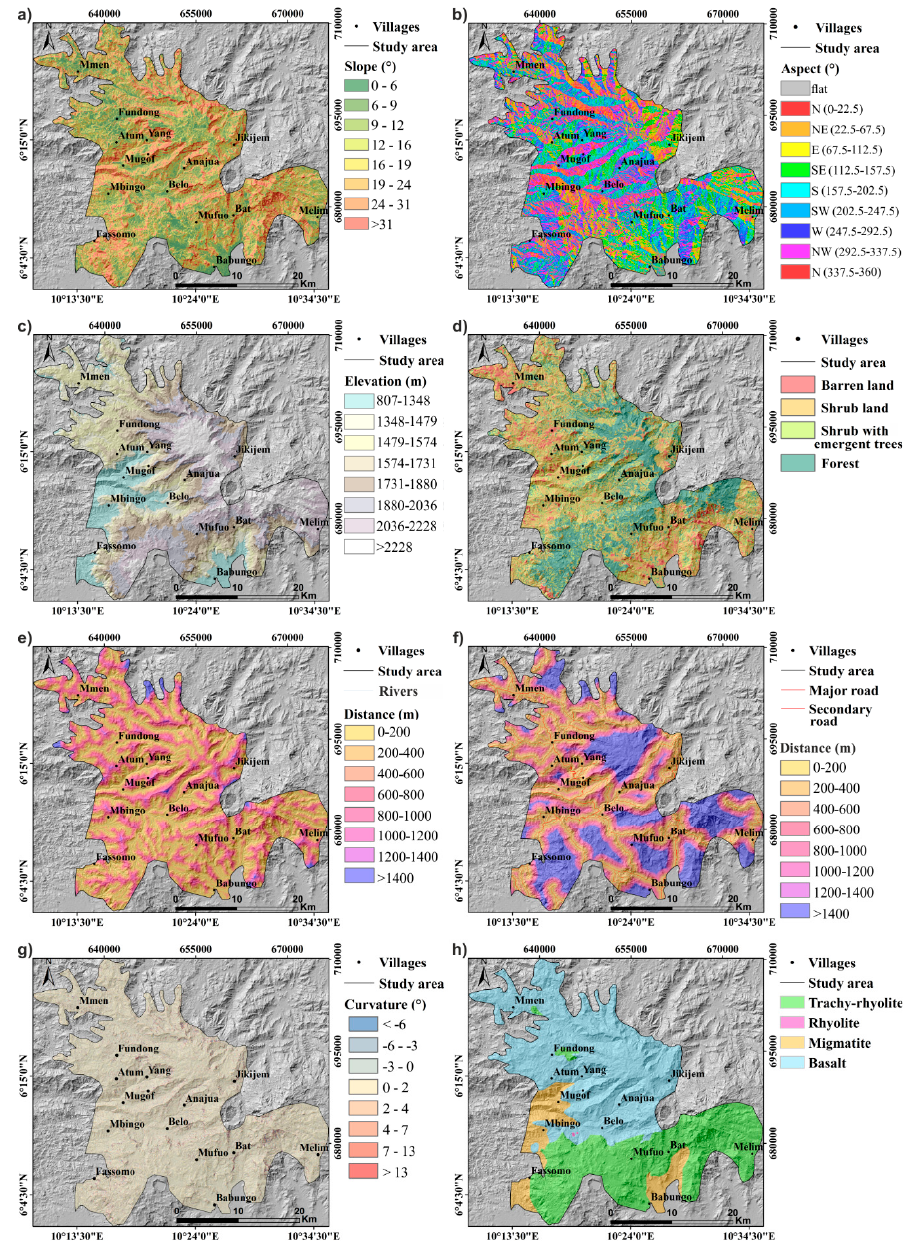
Figure 8. Geo-environmental factors maps reclassified into various classes with hill shade as base map: ( a ) Slope angle, ( b ) slope aspect, ( c ) elevation, ( d ) land cover, ( e ) distance to rivers, ( f ) distance to roads, ( g ) curvature, and ( h ) lithology.